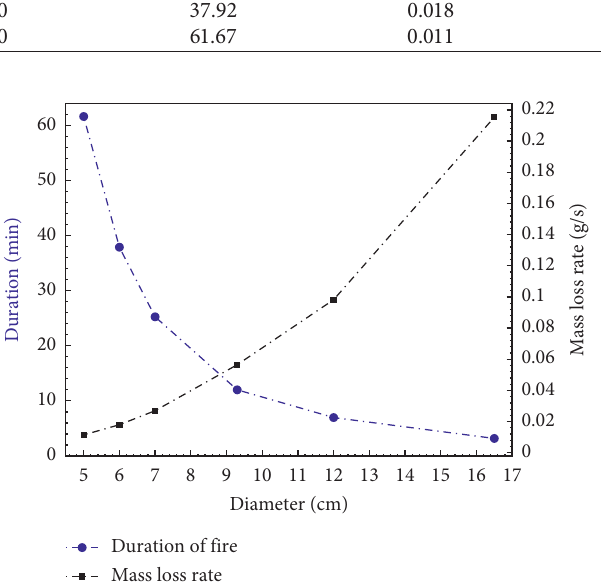
Figure 6: Variation of the fire duration and the fuel mass loss rate according to the fire source: case of fire in free atmosphere.